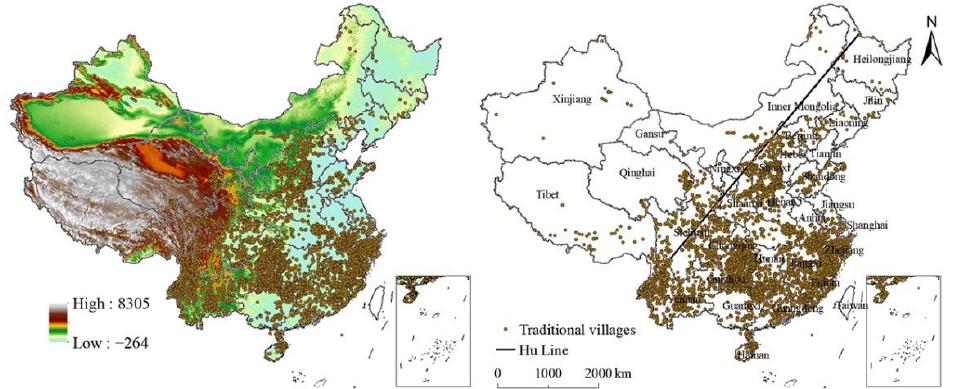
Figure 1. Spatial distribution of traditional villages in China.